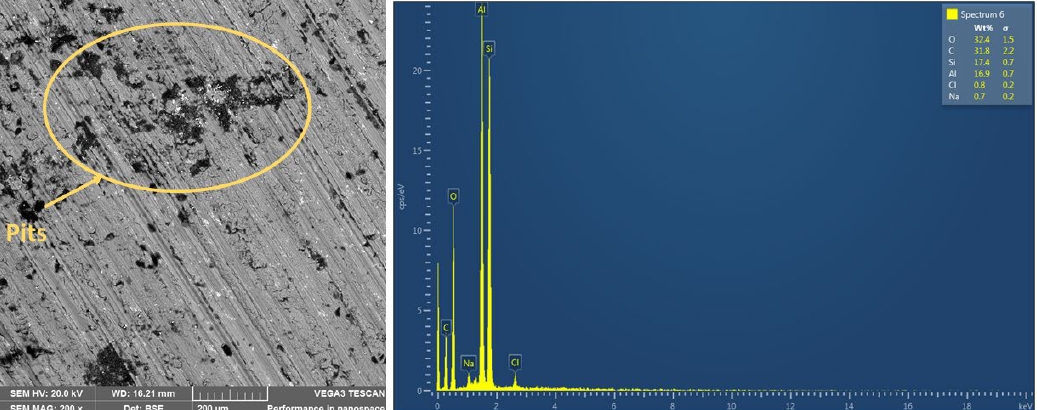
Figure 6. Scanning electron micrograph and EDS chart of 15% wood-particle-reinforced composite.